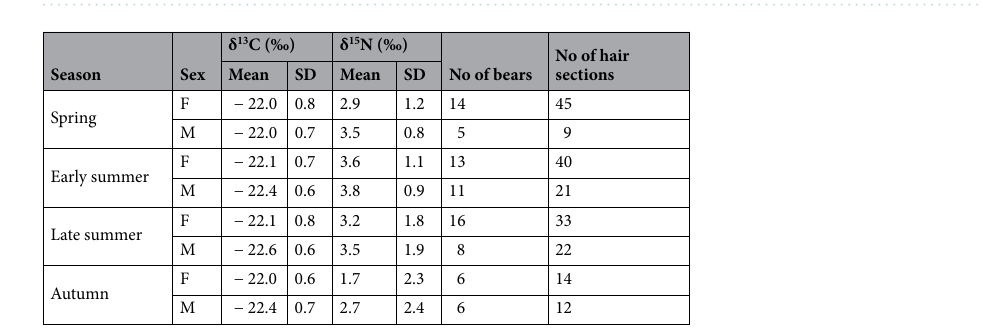
Figure 2. Distributions of posterior probabilities of each diet type for Apennine brow bears provided by stable isotope mixing models with informative priors (Abruzzo Lazio and Molise National Park, central Italy, 2013– 2014).